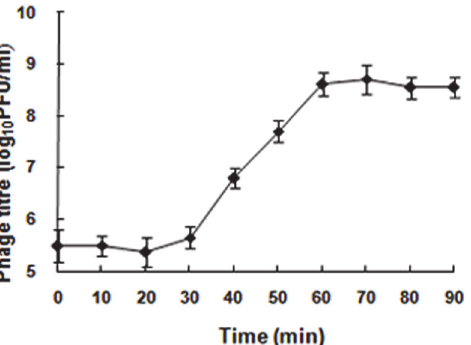
Figure 2. One-step growth curve of phage PPA-ABTNL. PPA-ABTNL phage was co-incubated with culture of PA5-1-1 to absorb for 5 min at 37°C. The mixture was centrifuged to remove non-absorbed phage. The re-suspended pellets were incubated at 37°C and sampled at 10 min interval over a period of 2 h. Phage titer was measured. Data represent mean (cid:1) SD from three independent experiments. n = 3.